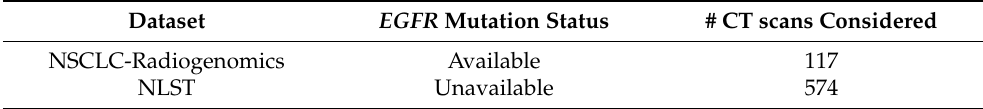
Table 1. Number of CT scans considered from each dataset.